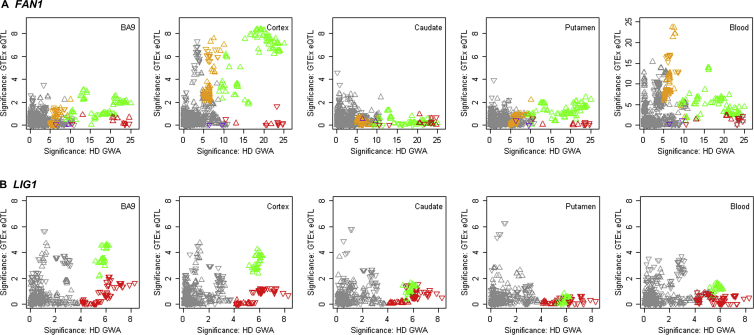
Correspondence between Onset Modifier Signals and GTEx eQTL Signals for FAN1 and LIG1, Related to Figures 4 and 5(A) Chromosome 15 onset modifier signals depicted (as in Figure 4) in red (15AM1), green (15AM2), purple (15AM3), and gold (15AM4) (x axis) were compared to GTEx eQTL signals (y axis) for brain regions and whole blood. Upward and downward triangles represent SNPs whose minor alleles were associated with increased and decreased expression levels of FAN1, respectively. Because SNPs tagging 15AM4 have alleles of close to equal frequency, the direction of the arrow varies depending on whether the minor or major allele is on the 15AM4 haplotype.(B) Chromosome 19 onset modifier signals depicted in red (19AM1) and green (19AM2) (x axis) were compared to GTEx eQTL signals (y axis) for LIG1 expression in brain regions and whole blood. The tag SNP for 19AM3 is too infrequent to appear in GTEx eQTL results. Upward and downward triangles represent SNPs whose minor alleles were associated with increased and decreased expression levels of LIG1, respectively.